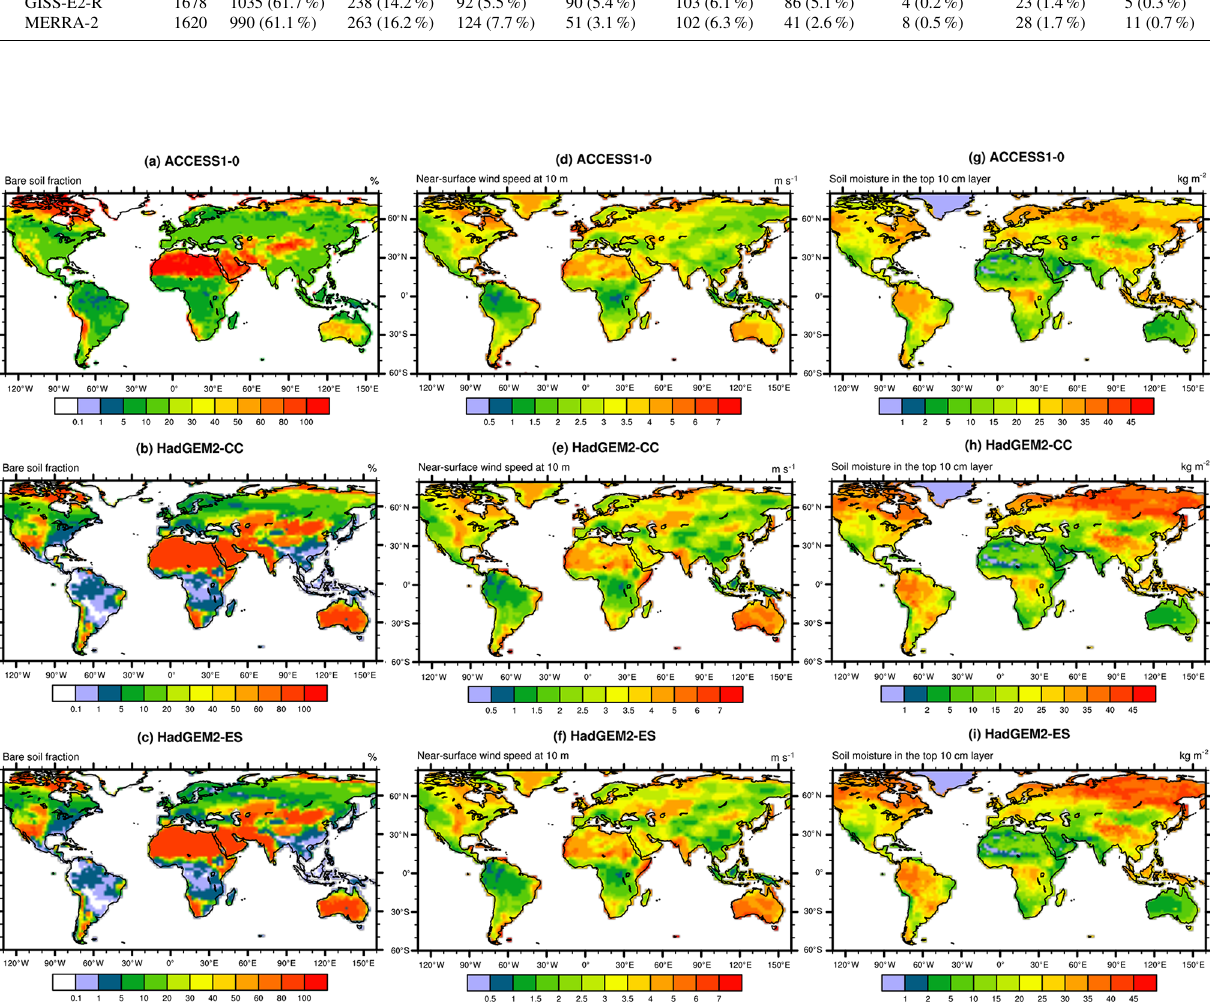
Figure 4. Bare-soil fraction (%), near-surface wind speed at 10m over land (ms − 1 ), and soil moisture in the top 10cm layer (kgm − 2 ) in ACCESS1-0, HadGEM2-CC, and HadGEM2-ES. Note that except for the bare-soil fraction in ACCESS1-0, which is prescribed and set constant for each year, the other results are all from model simulations during